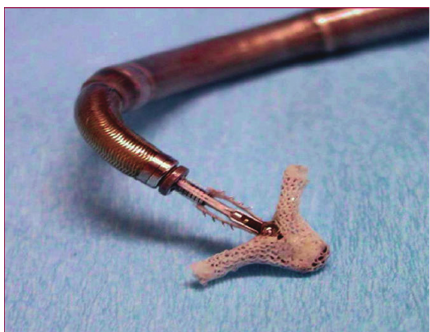
Figure 3: The Mitraclip device is a two-armed, polyester-covered, fixation device. Each arm has an opposing gripper that aids the leaflets in the clip by means of multipronged friction